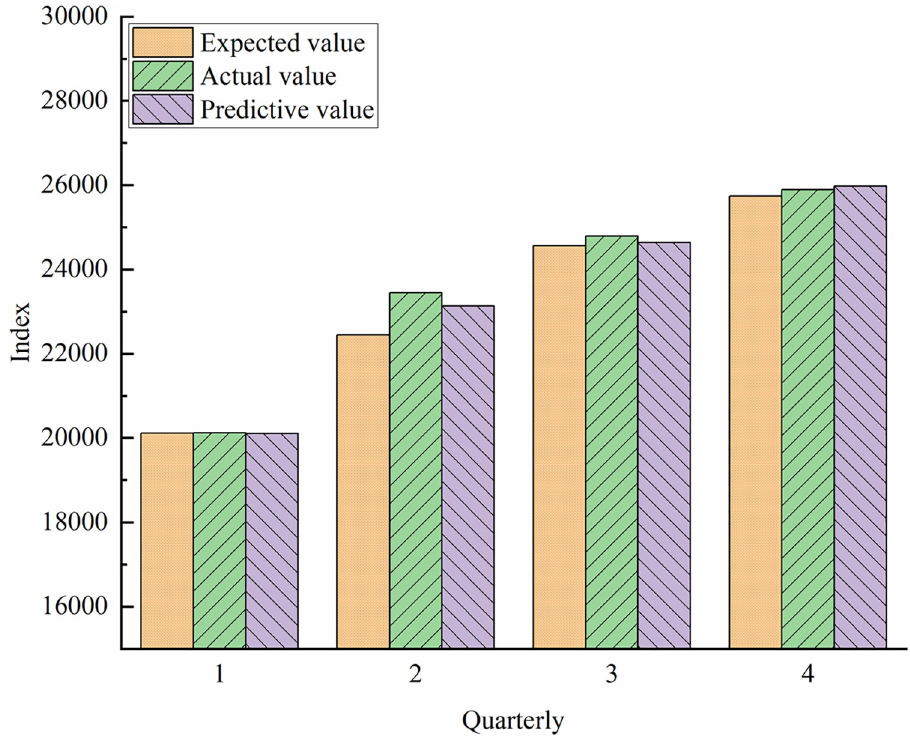
Fig 10. DPMES prediction value based on sample data inside and outside the